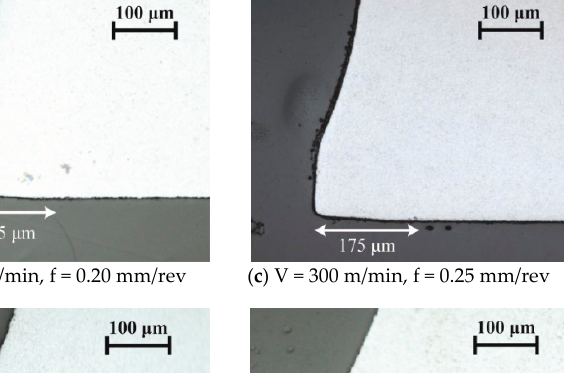
Figure 4. Schematics of edge geometries: ( a ) non-worn and ( b ) worn edge geometries.